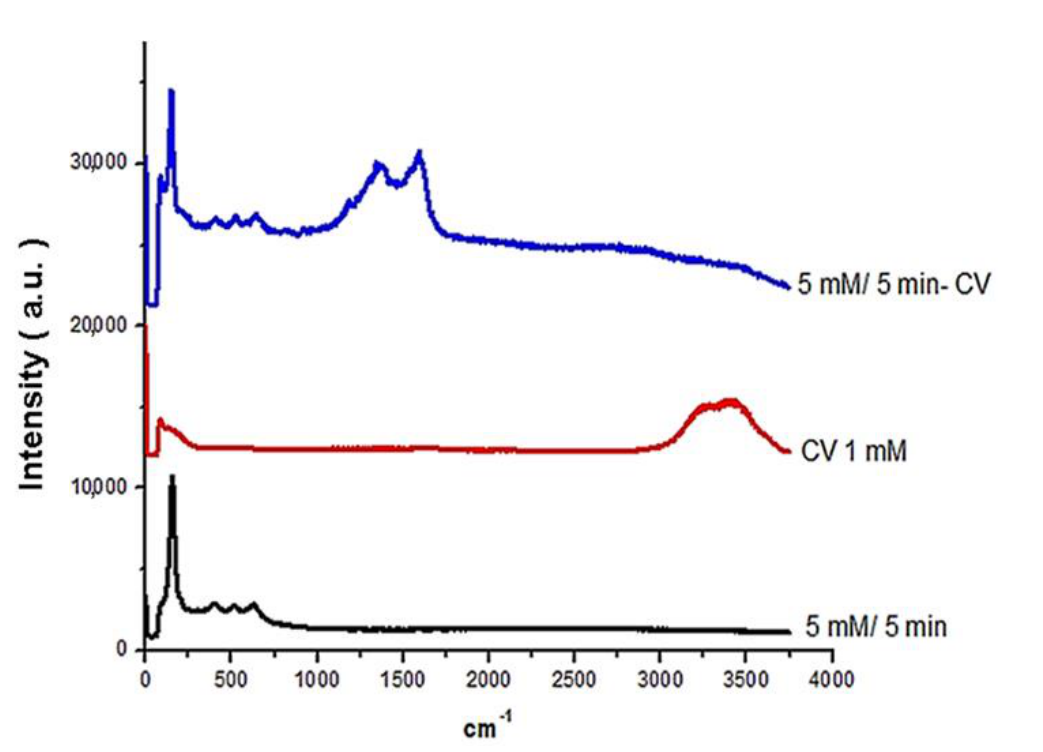
Figure 10. Raman spectra of crystal violet (CV) on the support doped for 5 min at 10 mM of AgNO 3 .